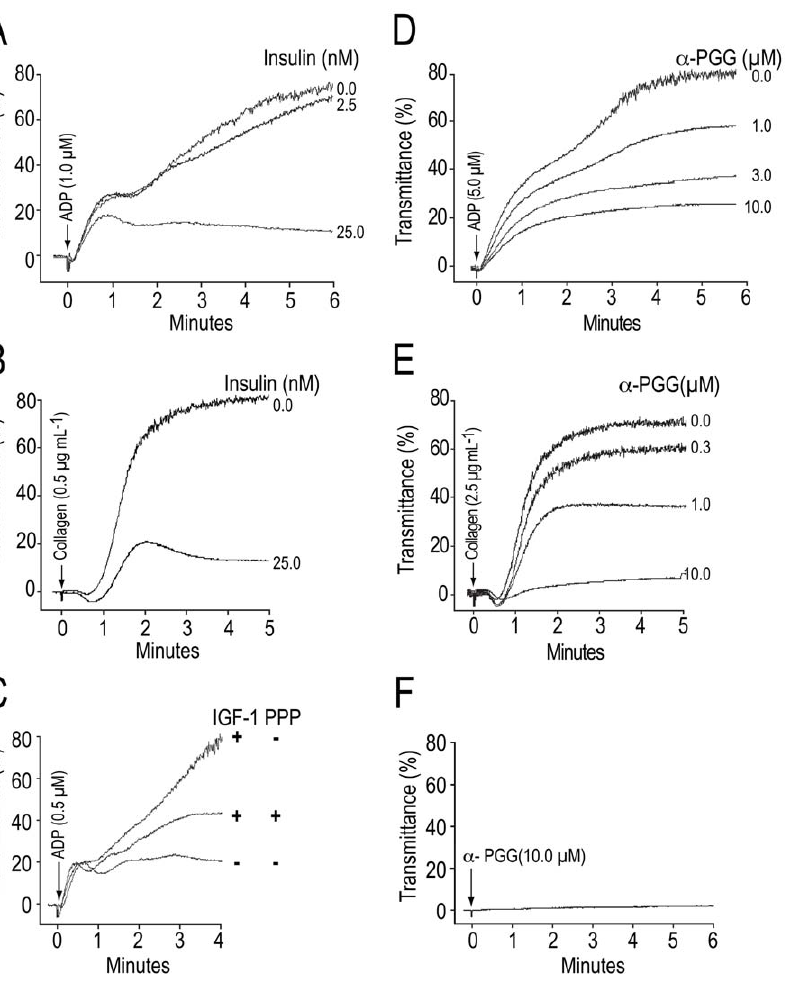
Figure 2. Insulin or a -PGG inhibited invitro platelet aggregation induced by ADP or collagen. Insulin (A, B) or IGF-1 (C) was added to PRP and a -PGG (D, E) was added to washed human platelets five min prior to stimulation with ADP or collagen and aggregation was monitored using an aggregometer from Chrono-Log-Corporation (Havertown, PA, USA). The aggregation tracings are representative of three experiments.